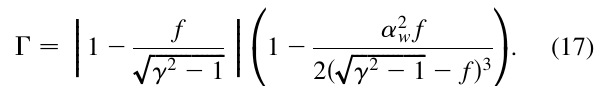
f ffiffiffiffiffiffiffiffiffiffiffiffiffiffiffi ffiffiffiffiffiffiffiffiffiffiffiffiffiffiffi